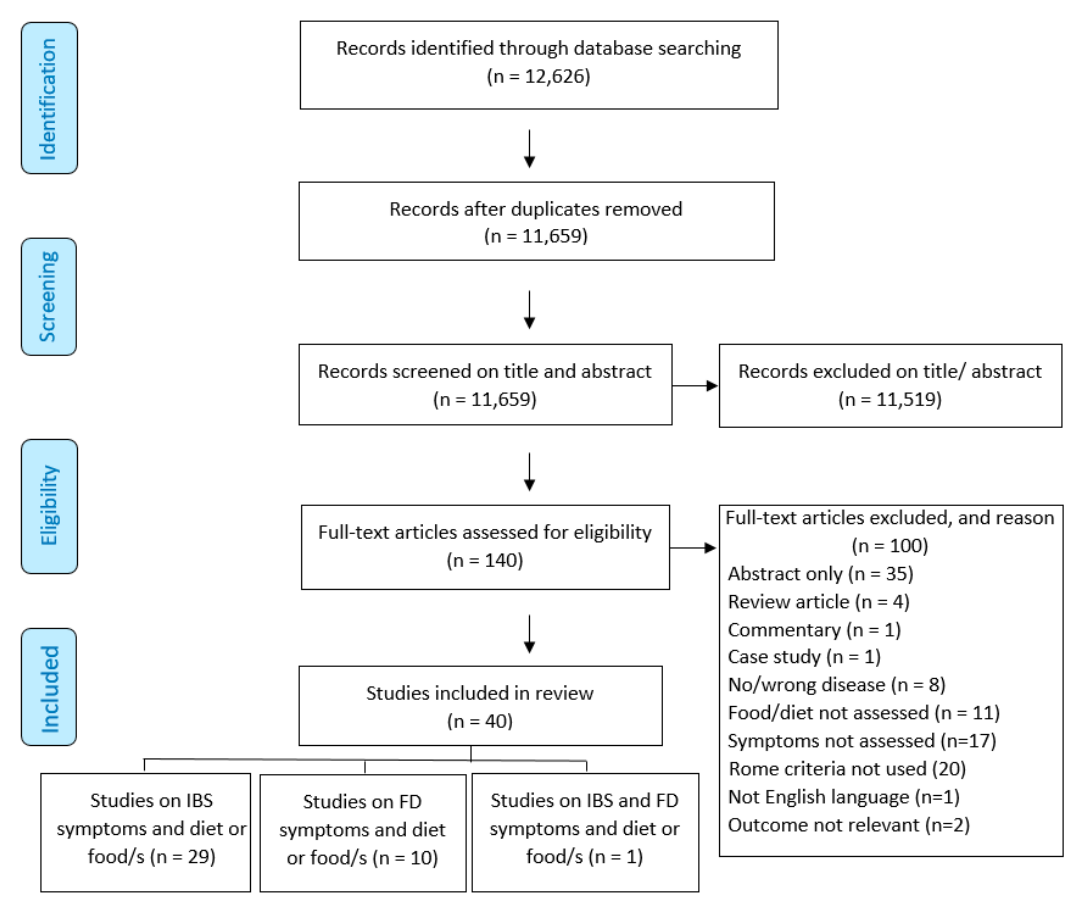
Figure 1. Search and screening for articles to include and exclude from a systematic review of alignment between assessment of dietary intake and functional GI disorder (FGID) symptoms.